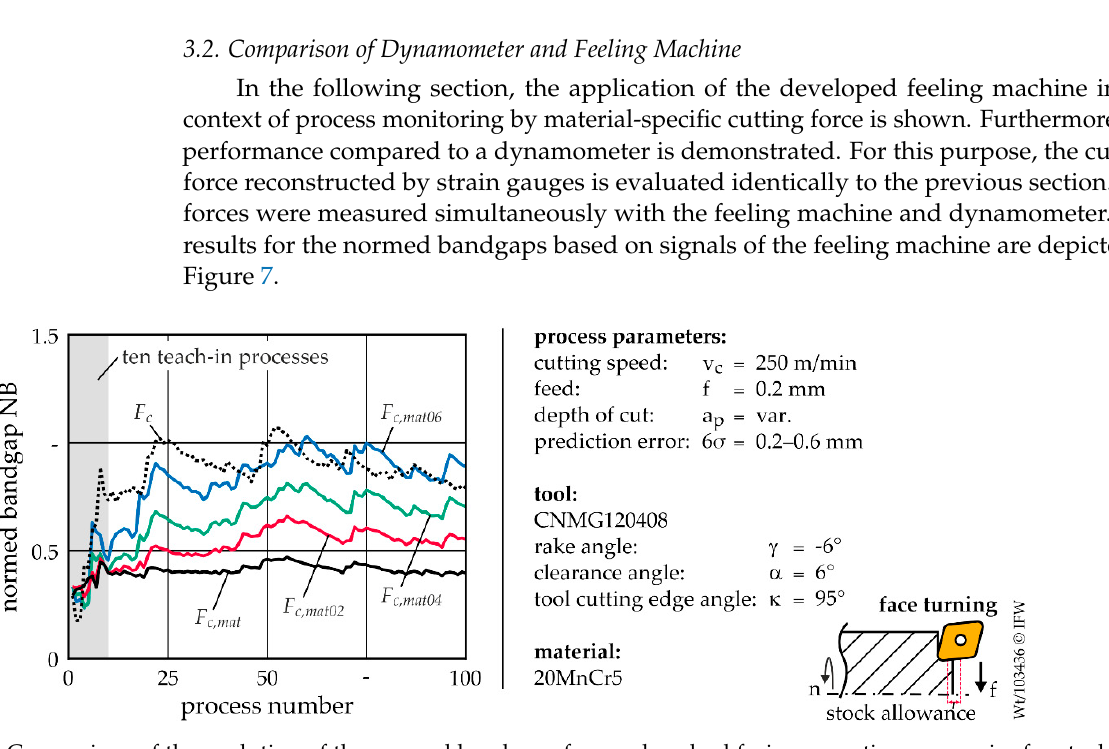
Figure 7. Comparison of the evolution of the normed bandgaps for one hundred facing operations per series for stock allowance variation A, deviation of the predicted geometry A and the different prediction error ranges by using signals provided by the feeling machine.